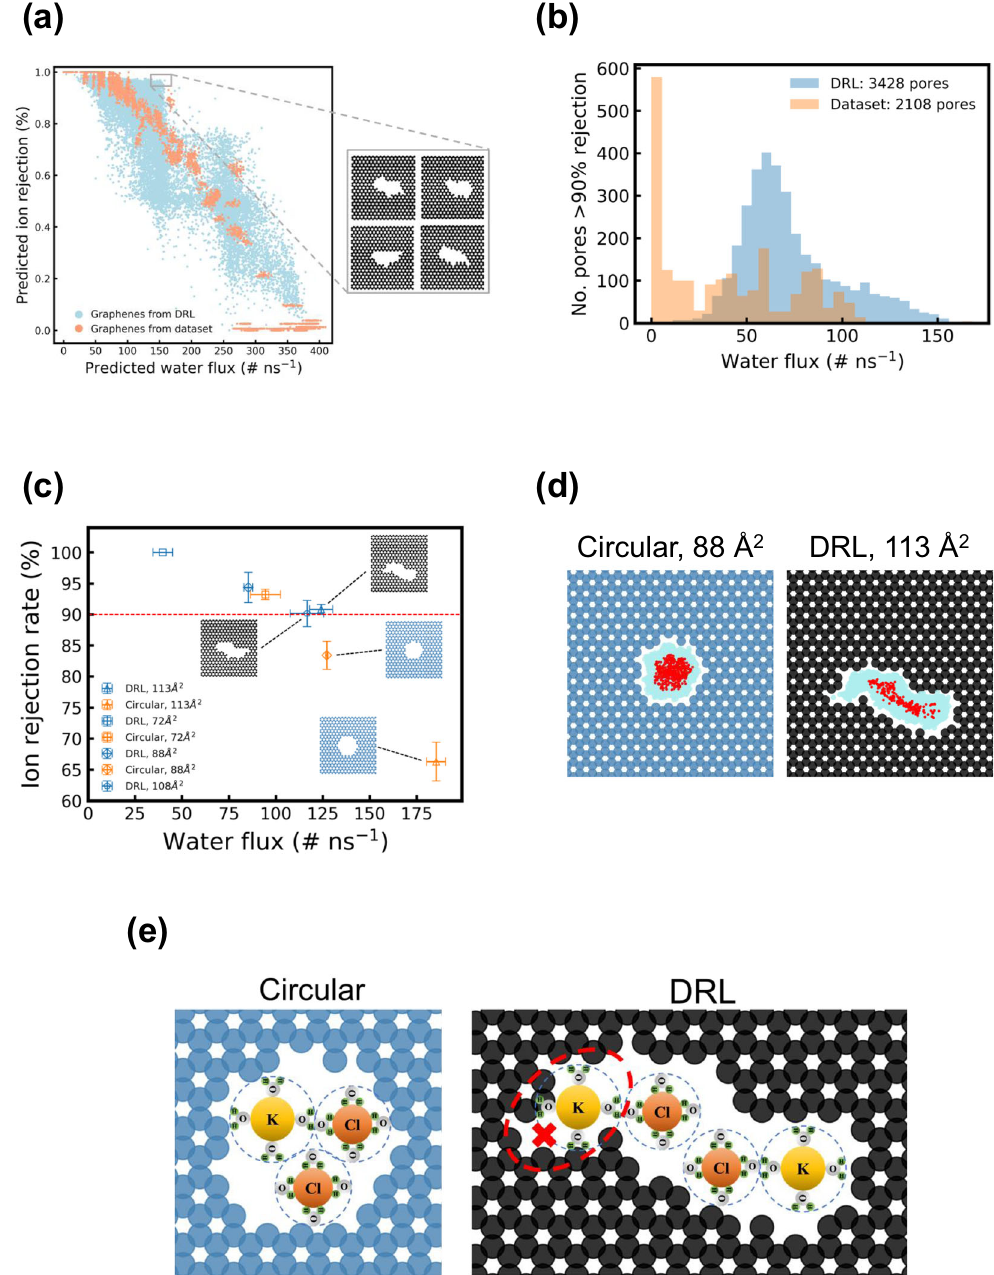
Fig. 5 Analysis of DRL-created graphene nanopores. a Predicted water fl ux (ns − 1 ) and ion rejection rate (%) of all graphene nanopores (7999 DRL-created + 3937 in training dataset). Zoom-in window shows the geometries of high-performance nanopores. b Histogram of water fl ux of nanopores with >90% ion rejection rate. c Comparison of water desalination performance (under 100 MPa pressure) of circular and DRL- created graphene nanopores. Each data point is obtained by averaging the ion rejection and water fl ux of 4 MD simulations. The error bars represent one standard deviation. d Distribution of water molecules (aqua blue) and ions (red) when they are inside of the nanopores (left: circular, area = 88 Å 2 ; right: DRL-created, area = 113 Å 2 ). e Schematic showing how ions are blocked by DRL-created pore due to the steric effect. Ions with their hydration shell (blue dashed circle) are too large to pass through the corner area (red dashed circle) in the DRL-created pore, thus rendering that area an ion-free traverse the circular pore evenly through the entire central area of nanopores can be stabilized by adding passivation such as the pore. The distributions of water molecules (marked by aqua hydrogen to the edge of the pore 43 . blue color) and ions in the circular pore are in a homogeneous To gain a deeper understanding of the reason behind the high pattern. However, the corners inside of DRL-created nanopore are ion rejection rate of DRL-created pores, distribution of water small enough to block the passage of ions while being large molecules and ions inside of 113 Å 2 DRL-created pore and 88 Å 2 enough to accommodate the transport of water molecules. With circular pore have been visualized (Fig. 5d). From the ion the knowledge that ions are covered by hydration shell during the distribution (marked by red dots), we can observe that ions can